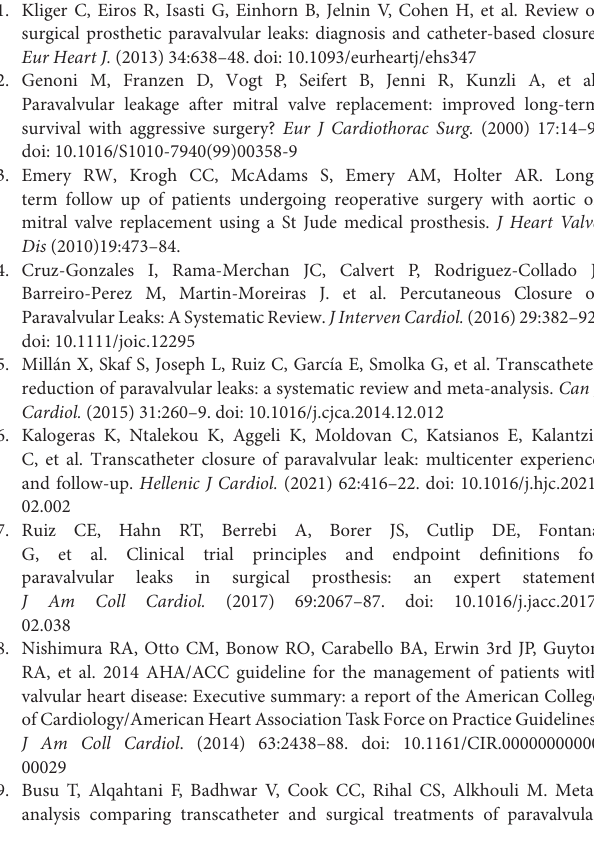
Supplementary Figure 1 | Post-procedure 2D X-plane (A) and short axis view (B) TEE color Doppler showing a regurgitant jet through a 10 × 4mm residual peri-device leakage. RW, rectangular waist; PLD, Occlutech Parvalvular Leak Device. Supplementary Figure 2 | Three-month follow-up 2D TTE (A) color Doppler (B) confirmed the stable position of the two PLDs with trace residual leak. PLD, Occlutech Paravalvular Leak